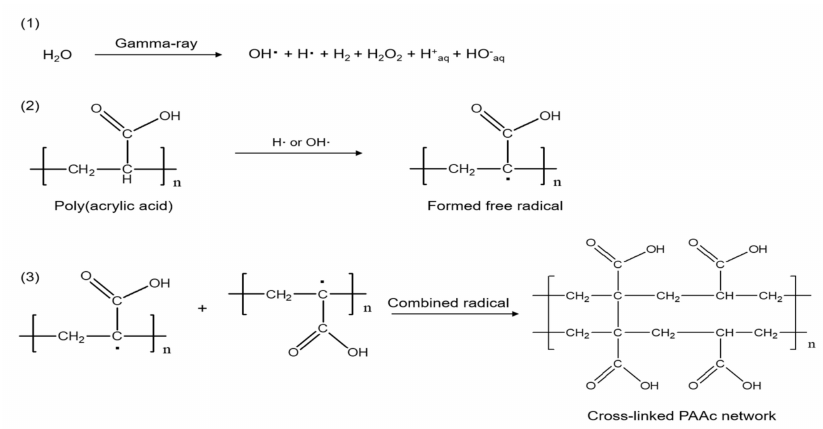
Figure 4. Mechanism of poly (acrylic acid) hydrogel formation using gamma-rays.